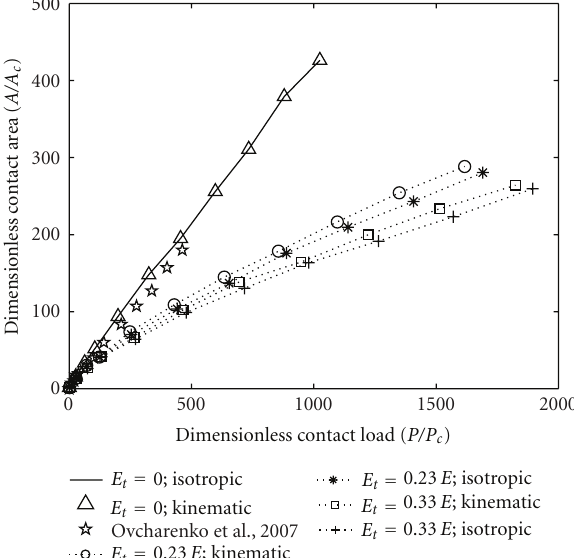
Figure 11: Dimensionless contact load versus dimensionless con- tact area for kinematic and isotropic material